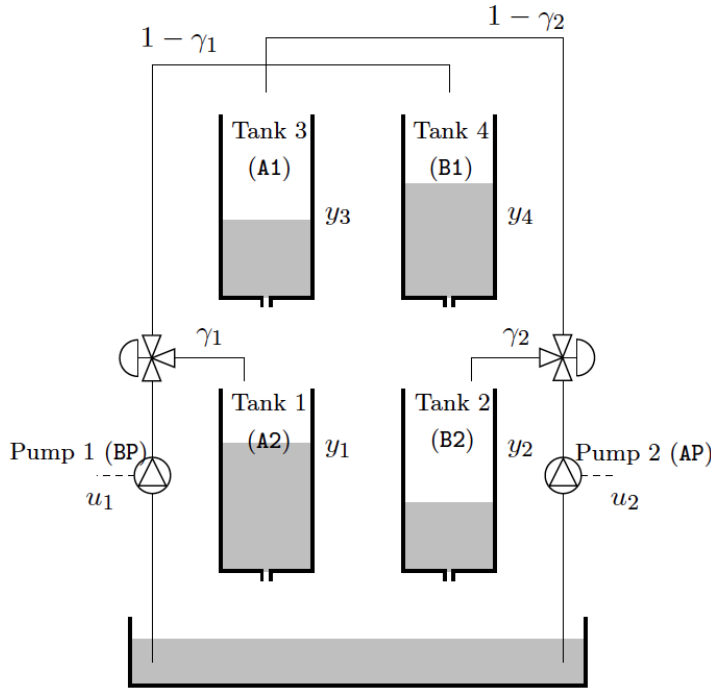
Figure 6. The quadruple tank